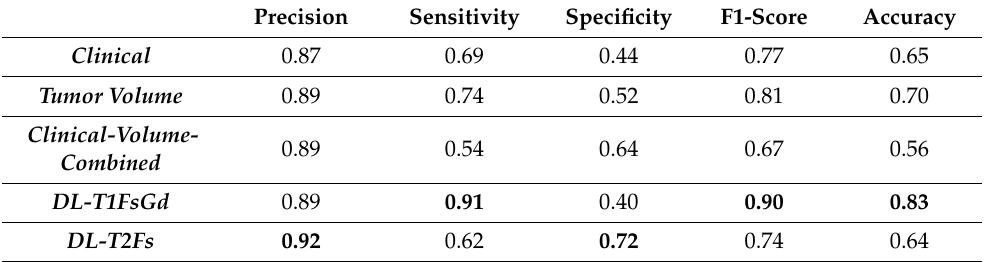
Table 2. Classification metrics for the test set. In bold, the best result among all models for each metric is